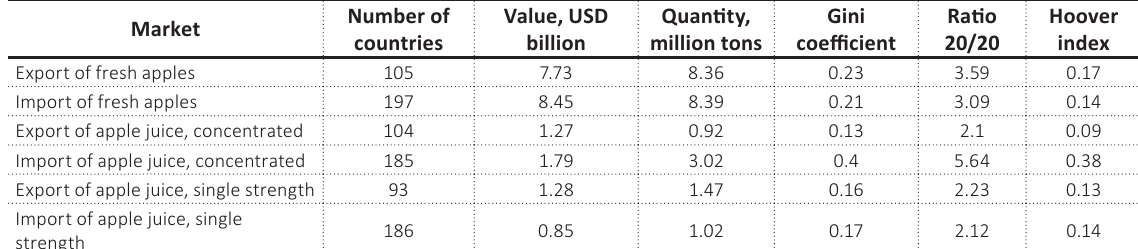
Source: Calculated by the